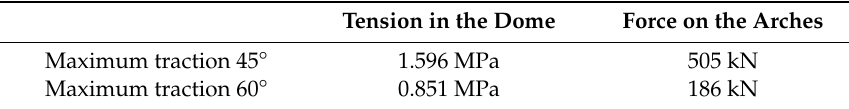
Table 12. Comparison of the tensions.